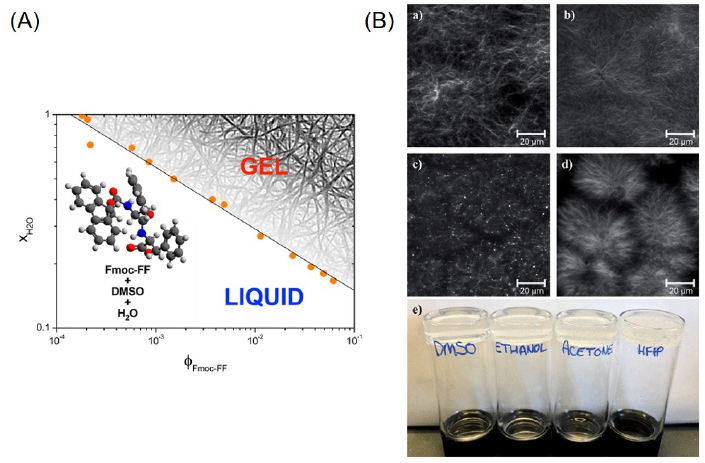
Figure 5. ( A ) Phase diagram molecular gels produced by Fmoc-FF using DMSO/H 2 O solvent-switch method (figure adapted with permission from Ref. [67], Copyright 2014 American Chemical Society). ( B ) Fmoc-FF matrices stained with Nile Blue in confocal microscopy analysis ( φ solvent = 0.3) using the solvents ( a ) DMSO ( b ) ethanol ( c ) acetone ( d ) HFIP, ( e ) macroscopical gel picture after 24 h from their preparation (at same φ solvent without staining) (figure reproduced from Ref. [71] with permission from the Royal Society of Chemistry).